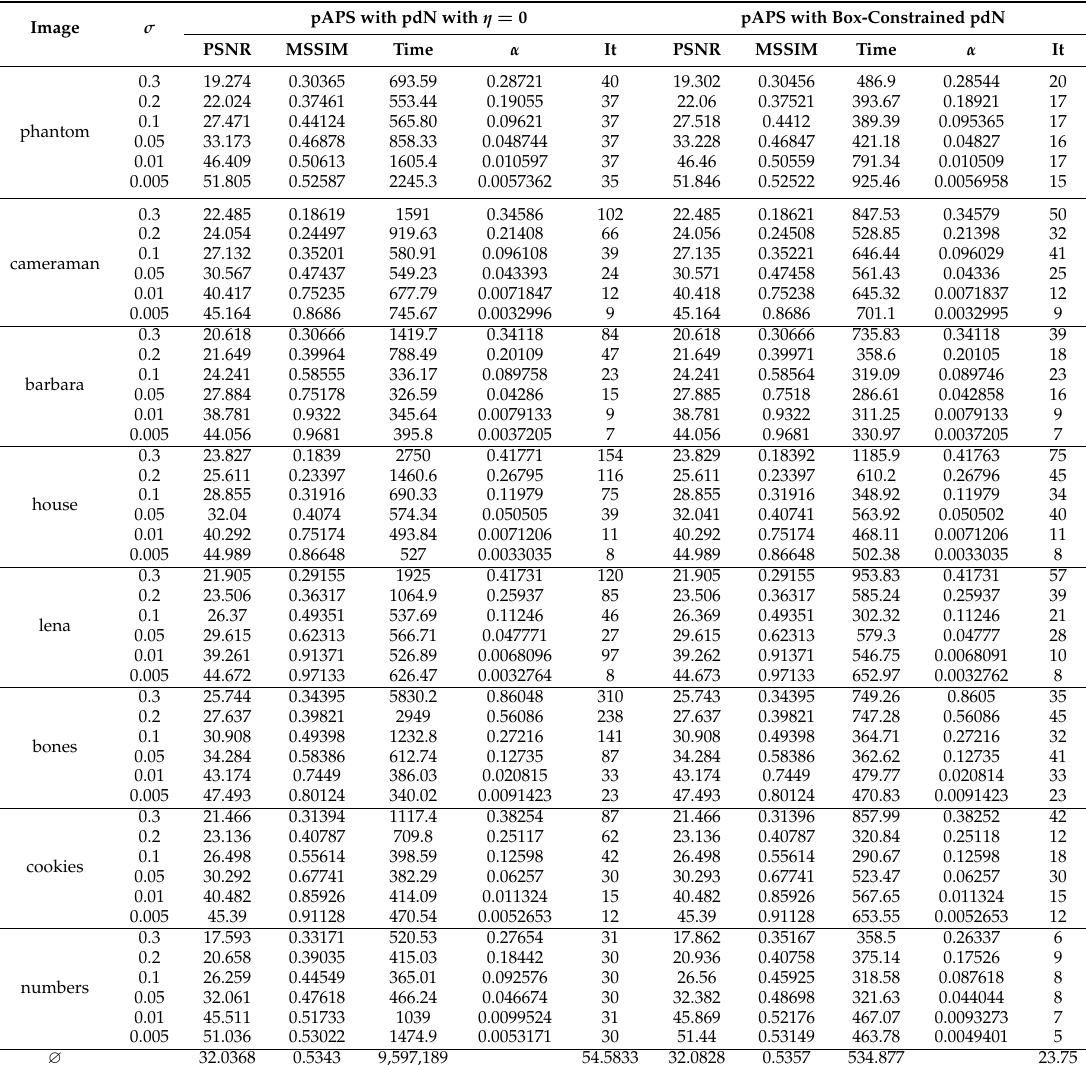
Table 7. PSNR- and MSSIM-values of the reconstruction of different images corrupted by Gaussian white noise via pAPS using the primal-dual Newton